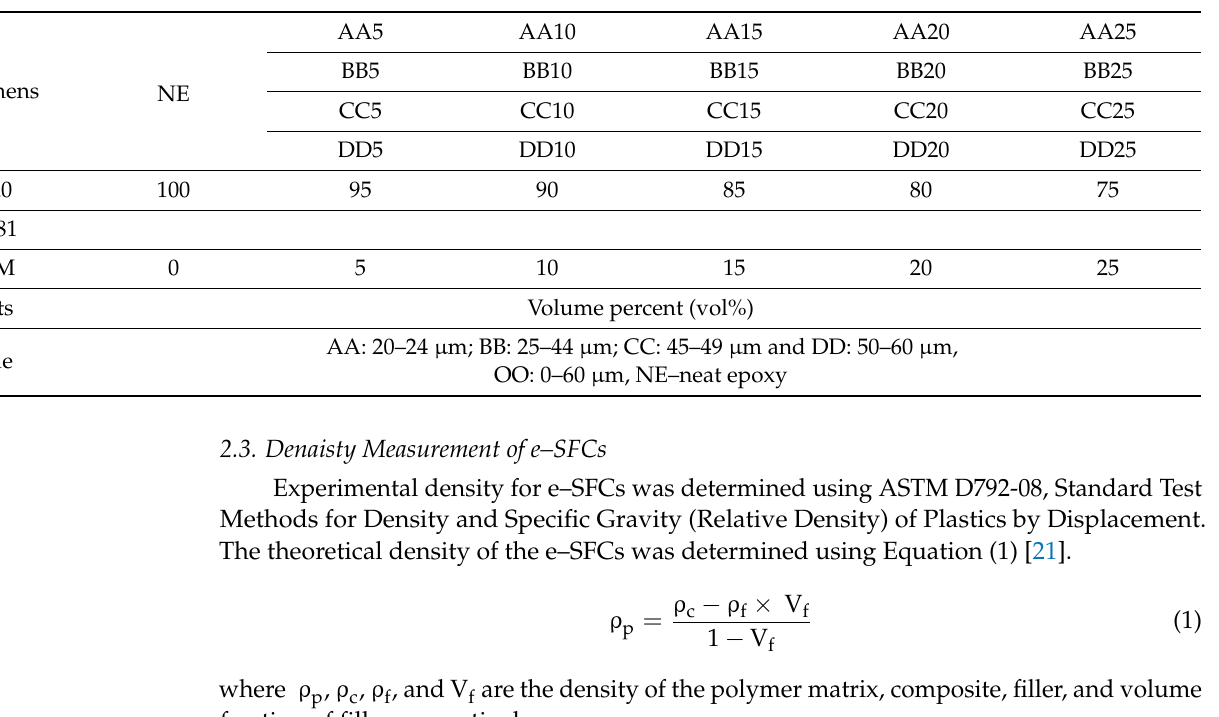
Figure 1. Schematic diagram for the particle size variation analysis by gas pycnometer. Table 1. Formulation for fabrication of